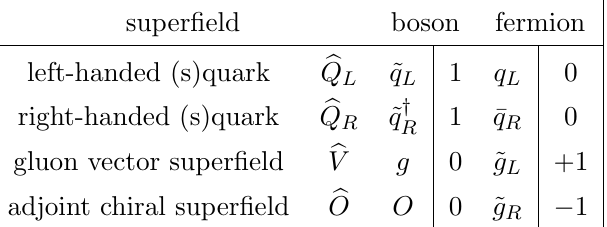
Table 1. The table shows the strongly interacting (cid:12)eld content of the MRSSM, together with the R-charges of the component (cid:12)elds. The super(cid:12)eld in the last line is absent in the MSSM. It comprises of the right-handed component of the Dirac gluino and two real